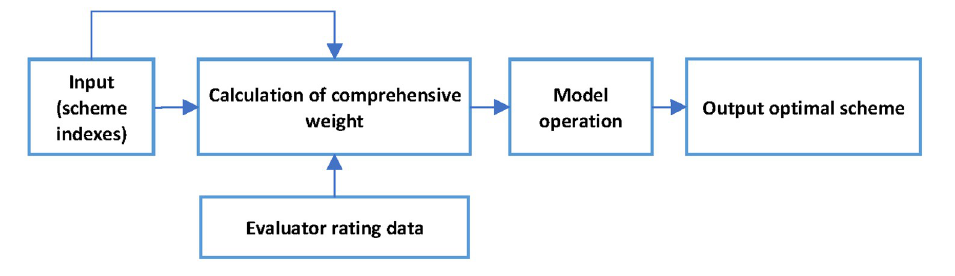
Fig 2. Scheme optimization